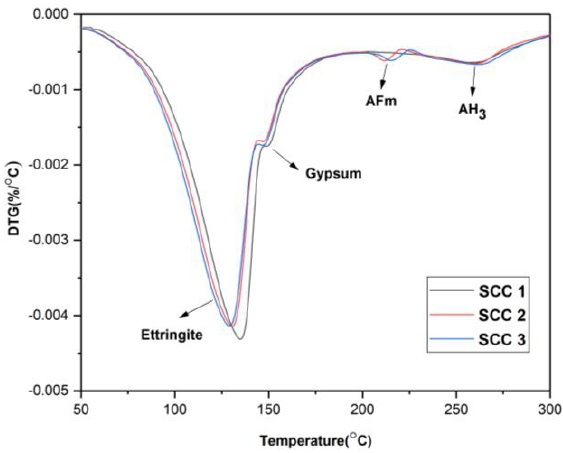
Figure 9. DTG curves of samples SCC1-SCC3 at 3 days of age.